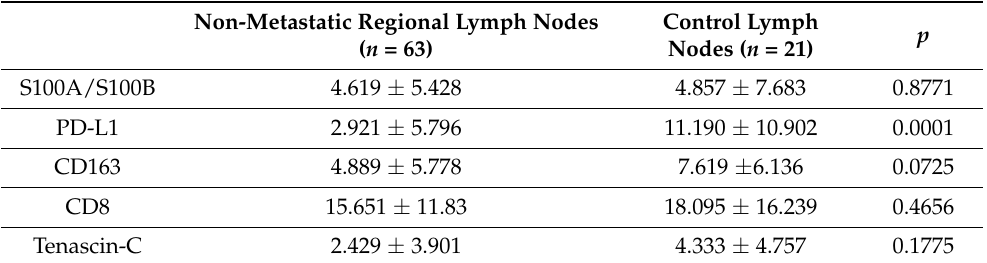
Table 2. Comparison between regional cancer-draining lymph nodes and non-cancer-draining lymph